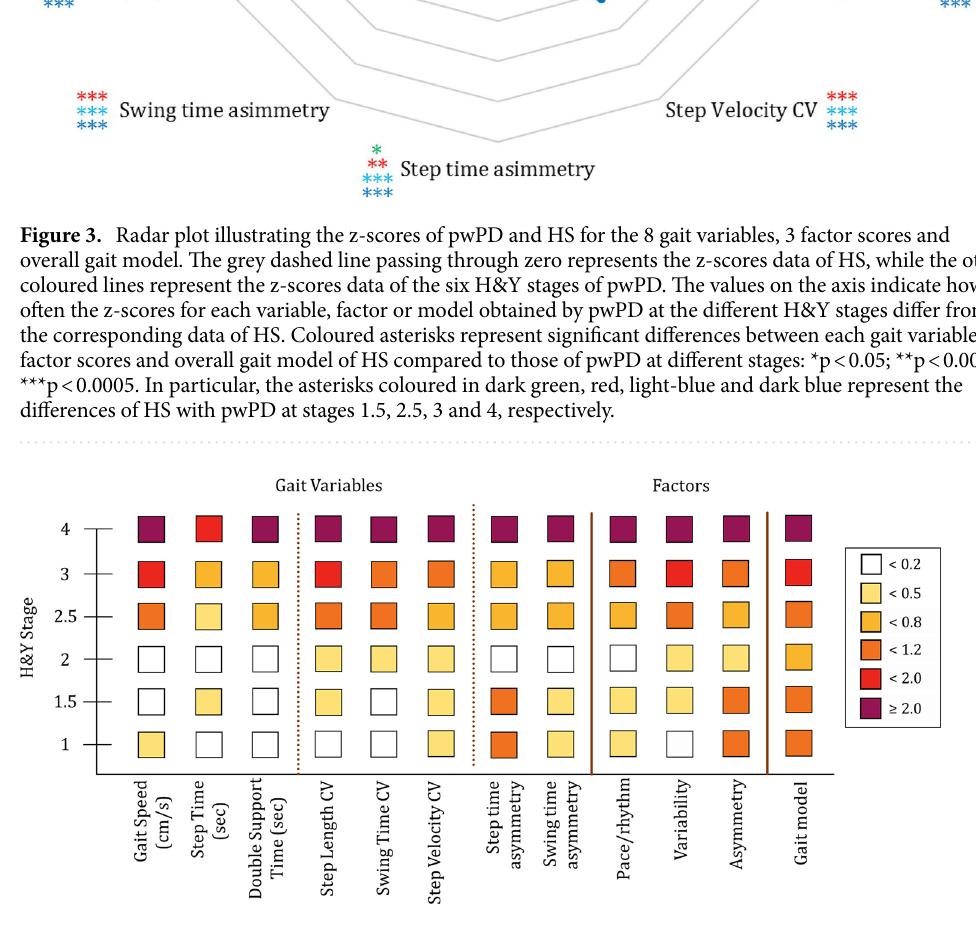
Figure 4. Effect sizes (ES) for the differences between pwPD (at each H&Y stage) and HS for each of the 8 gait variables, 3 factor scores and the gait model (abscissa). The magnitude of each ES for each stage of the H&Y scale (ordinate) is marked in colours according to the palette shown on the right: dark red > 2, huge effect; red > 1.2, very large effect; orange > 0.80, large effect; yellow 0.50–0.79, medium effect; sand 0.20–0.49, small effect; white < 0.20, no